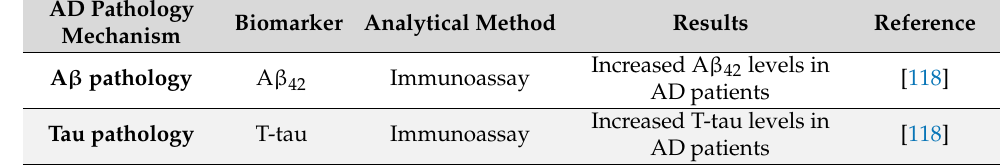
Table 8 summarizes the results of core AD biomarker studies using tears. Table 8. Summary of core AD biomarkers in